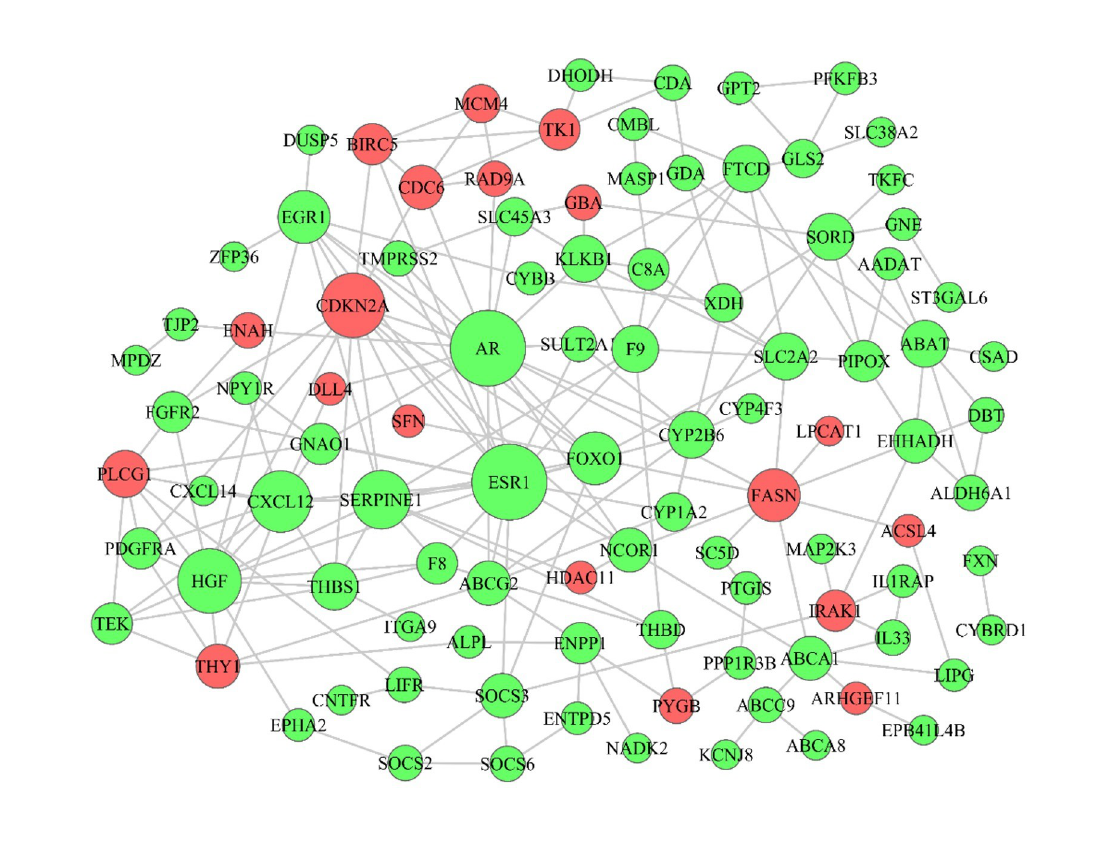
Fig 5. Protein–protein interaction network. All the points are differentially expressed mRNAs, node size represents regulatory capacity of mRNAs. The regulatory capacity was stronger with larger size. Green represents downregulated mRNAs. Red represents upregulated